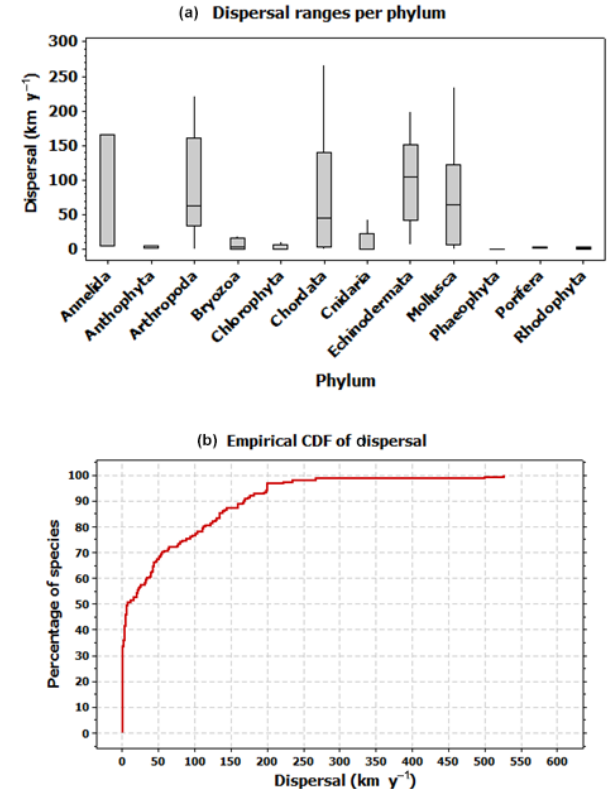
Figure 4. (a) Dispersal rates per different orders of species (in kmyr − 1 ), data from a search in the data set described in Mous- takas and Karakassis (2005, 2009). The solid line is the median, and the boxes are defined by the upper and lower quartiles (25th and 75th percentiles). The whiskers extend up to 1.5 times the in- terquartile range of the data. (b) Empirical cumulative density func- tion (ECDF) of the dispersal range of each species (in kilometres) against the percentage of species in the data set that have a dispersal potential less than or equal to that value. ECDF shows the percent- age of species that exhibit a dispersal range (kmyr − 1 ) less than or equal to the value on the horizontal